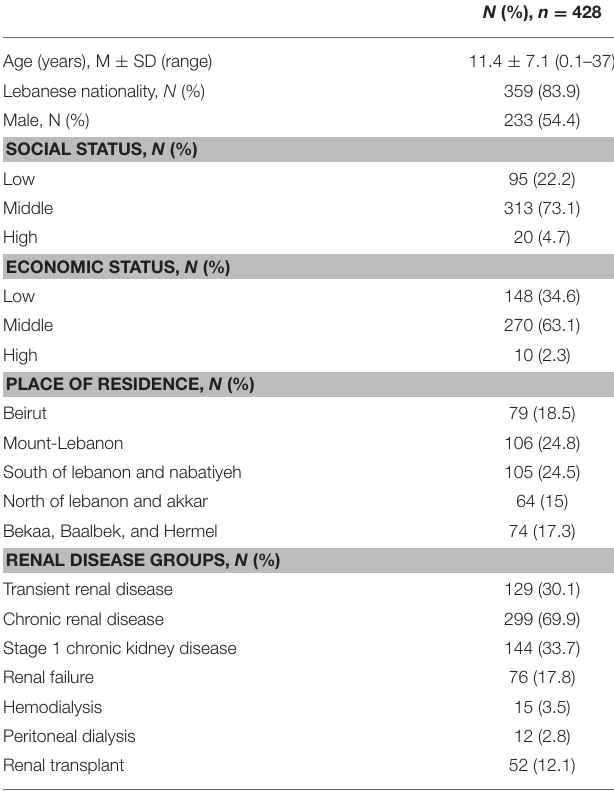
TABLE 1 | Demographic characteristics and study